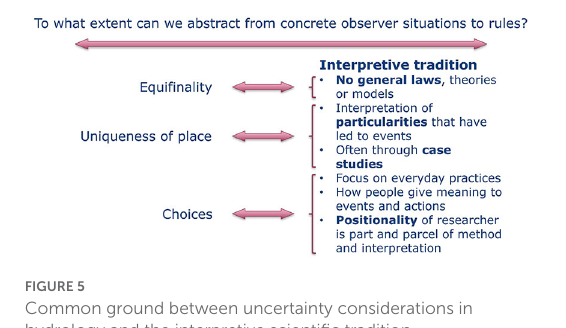
FIGURE5 Common ground between uncertainty considerations in hydrology and the interpretive scientific tradition (own